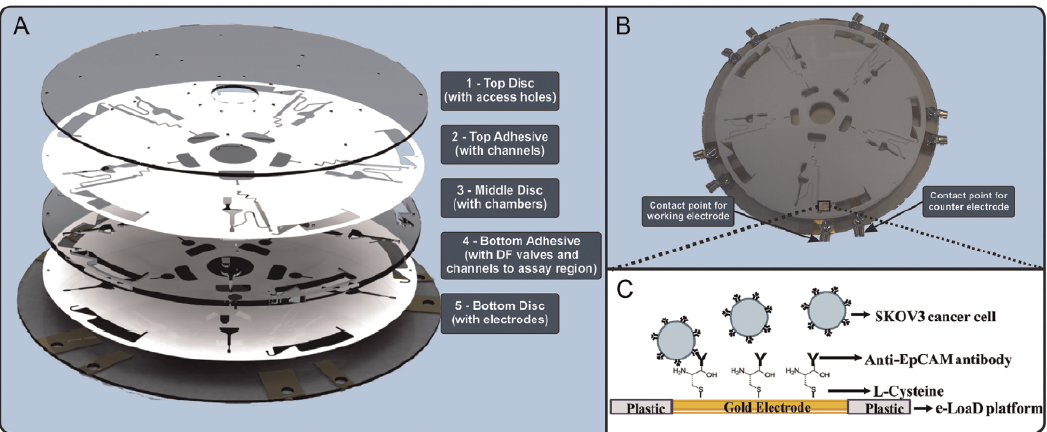
Figure 10. ( A ) Rendered 3D image of the five-layer microfluidic disc platform comprising three 1.5-mm thick PMMA discs and two 90- μ m thick pressure sensitive adhesive films. The gold electrodes were deposited on the bottom (layer 5) of the disc. ( B ) Fully assembled disc showing contact points for the working and counter electrodes. ( C ) Schematic of electrochemical cancer cell capture assay on polymeric eLoaD platform. Reproduced with permission from [76].